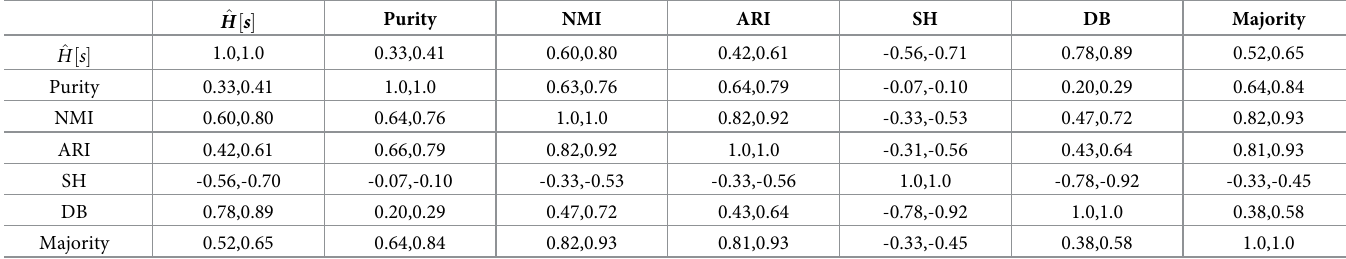
Table 9. Kendall’s τ and Spearman’s correlation result for TREC.